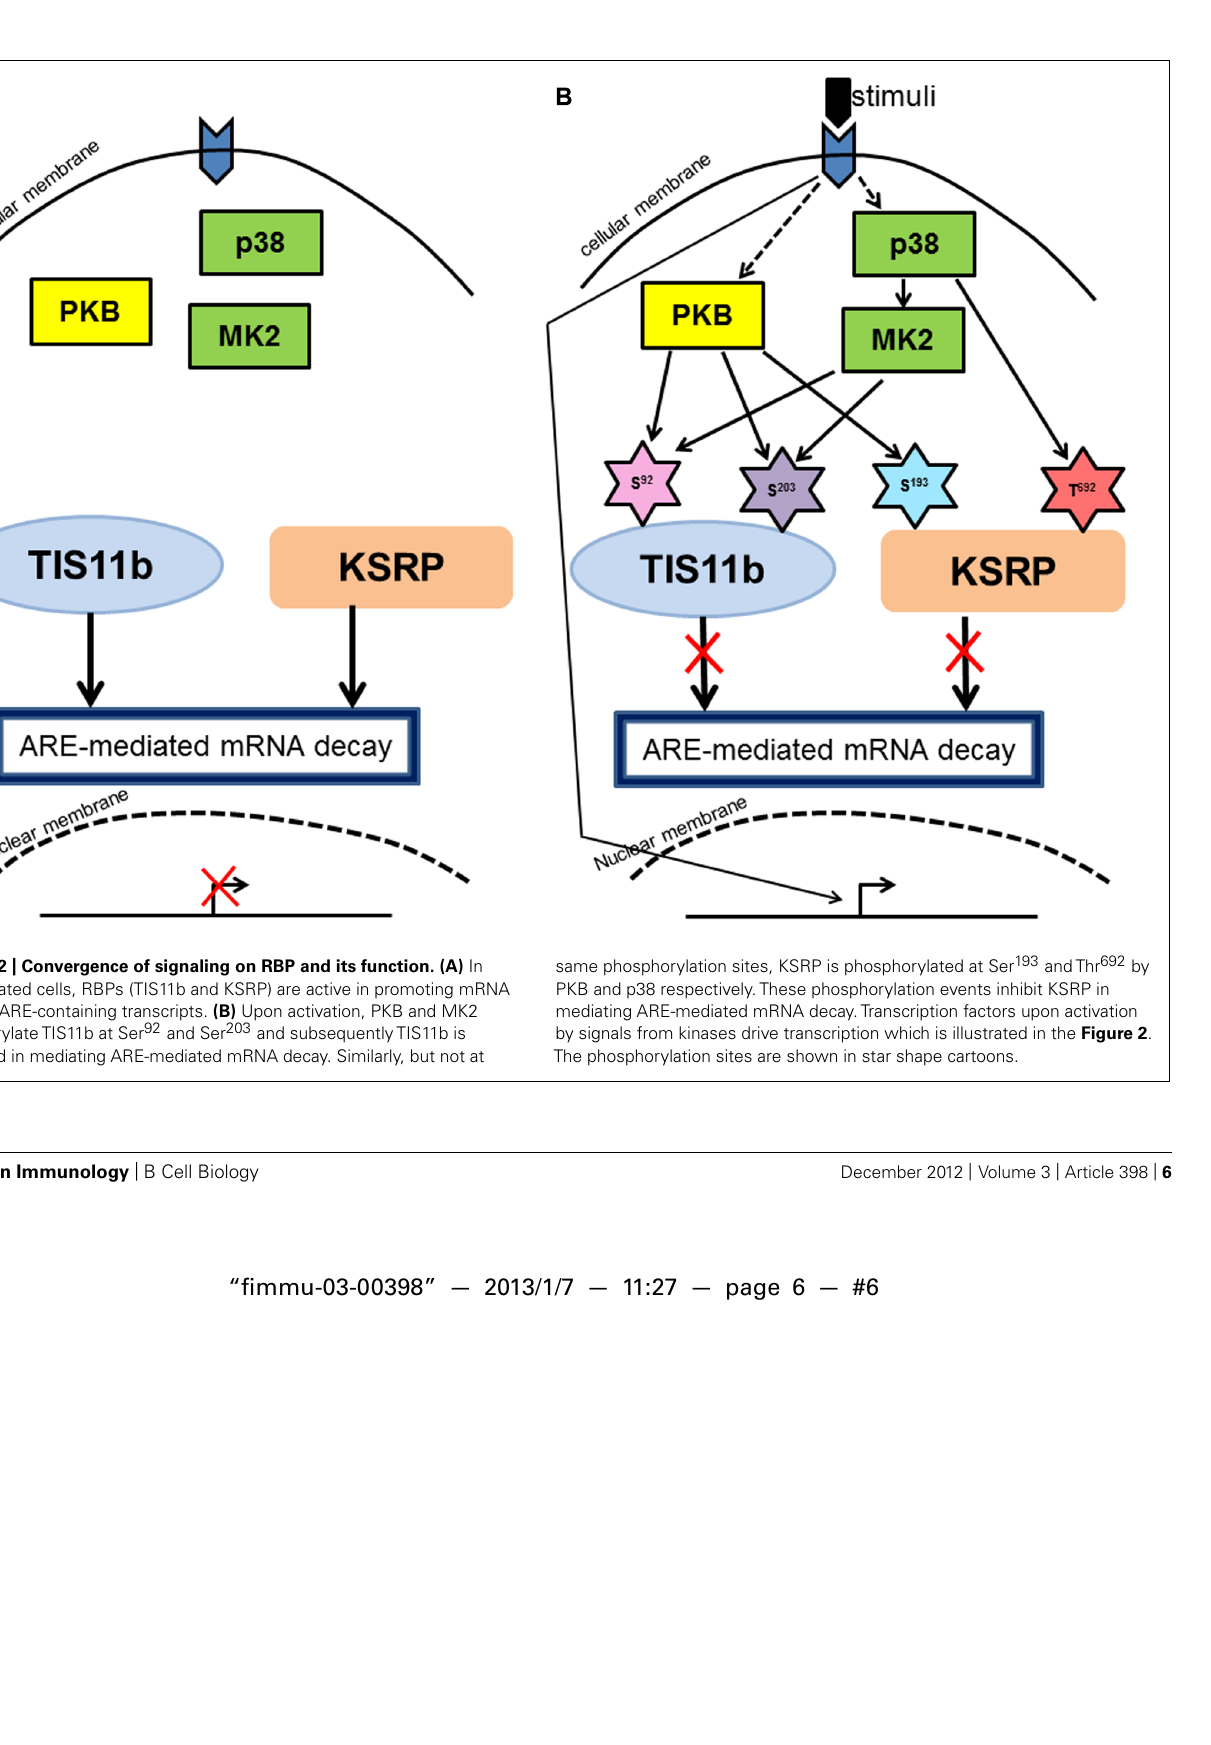
FIGURE 2 | Convergence of signaling on RBP and its function. (A) In non-activated cells, RBPs (TIS11b and KSRP) are active in promoting mRNA decay of ARE-containing transcripts. (B) Upon activation, PKB and MK2 phosphorylateTIS11b at Ser 92 and Ser 203 and subsequentlyTIS11b is prevented in mediating ARE-mediated mRNA decay. Similarly, but not at